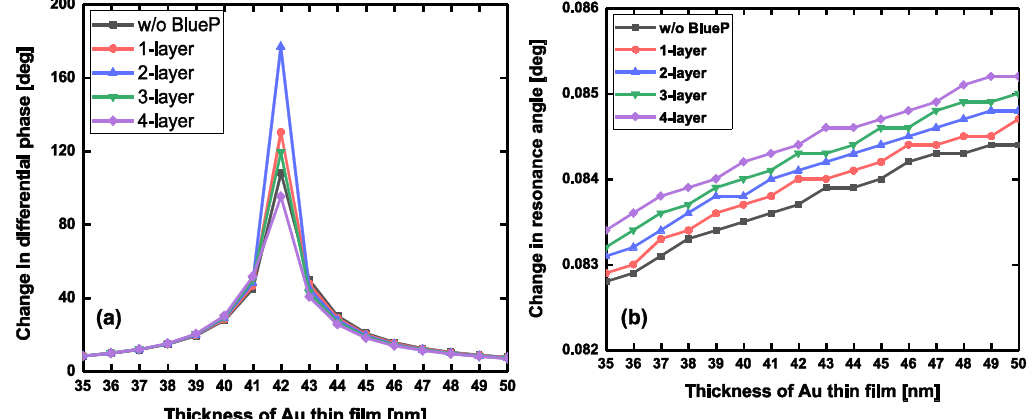
Figure 5. For a tiny refractive-index variation as small as 0.0012 RIU approaching the sensing interface, the change in differential phase ( a ), red-shifts based on SPR incident angle ( b ) with respect to the thickness of gold film ranging from 35 to 50 nm. The excitation wavelength is 632.8 nm.